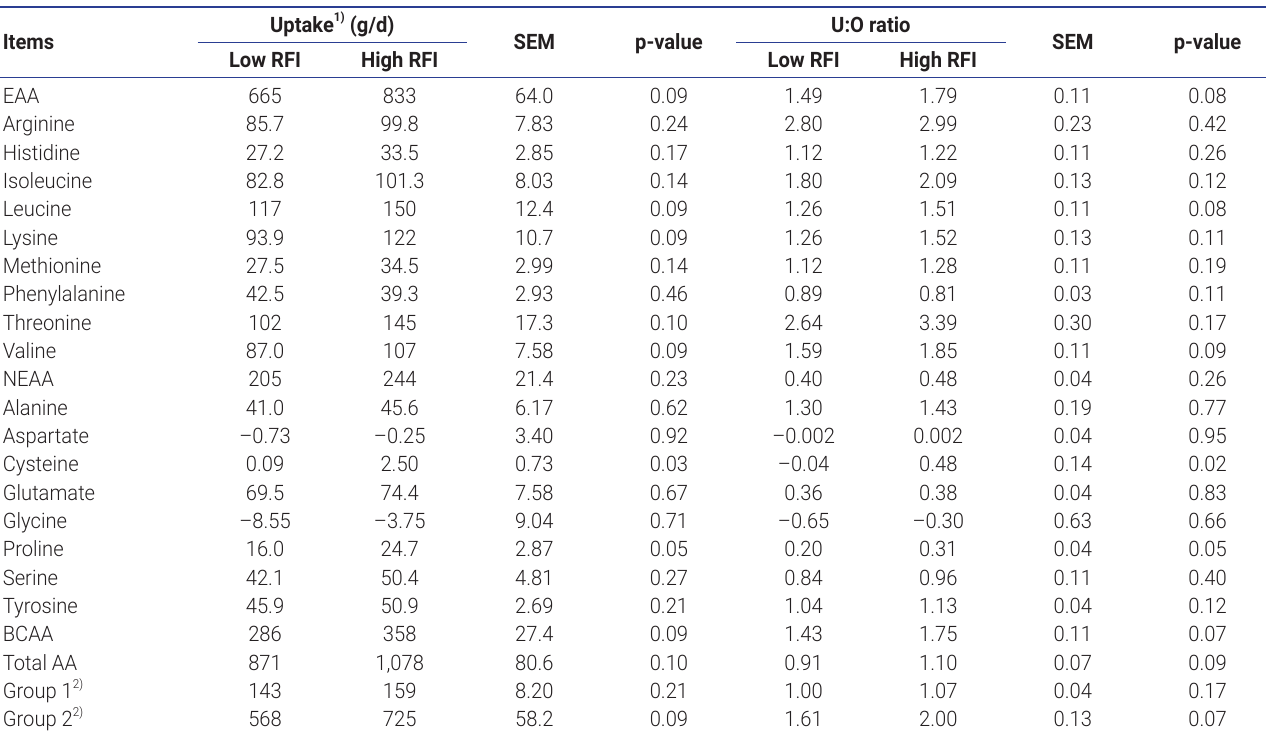
Table 5. Uptake of amino acids and ratio of uptake to output of amino acids in lactating cows selected for phenotypic divergence in residual feed